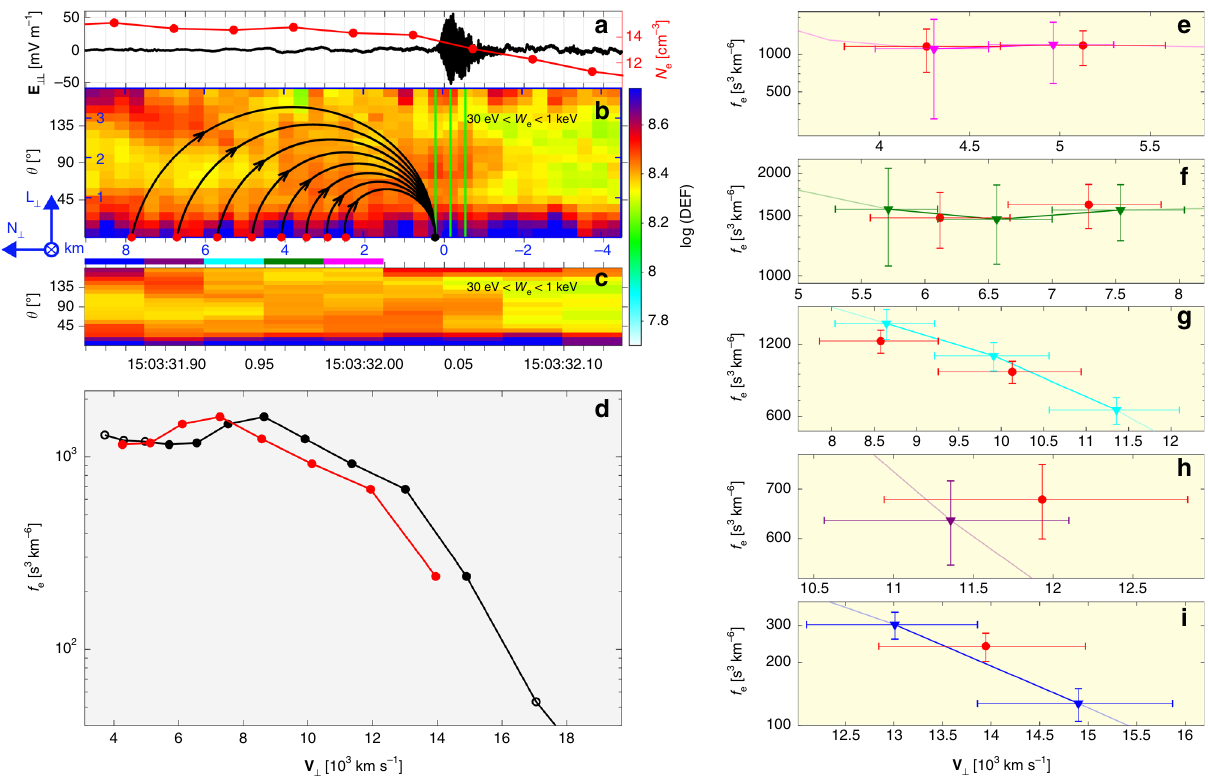
with f > 50 Hz and N . b Electron pitch-angle spectrogram using 7.5 ms FPI data and L e p ffiffiffiffiffiffiffiffiffiffiffiffiffiffiffiffiffiffi V ¼ ð 8 ± 2 : 1 Þ ´ 10 3 km s (cid:1) 1 . The electron dis- Φ = m ± 2 q ph e e